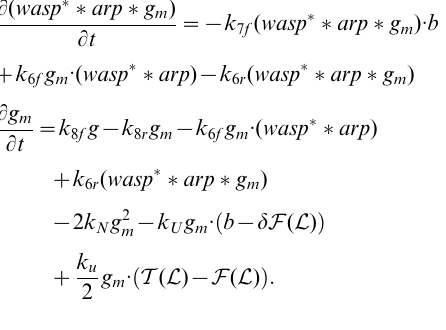
Here L ~ p z r z c while F ( L ) ~ L ( : ,0) and T ( L ) ~ L ( : , L z ) represent the pointed-end density at the lower and upper ( z ~ 0 and z ~ L z ), respectively. Parameters used for numerical simula- tions are presented in the Analysis section.